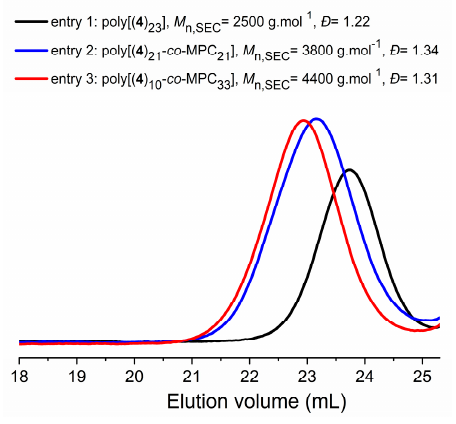
Figure 3. Overlaid SEC traces of the phosphonate-functionalized (co)polycarbonates synthesized in Table 1.